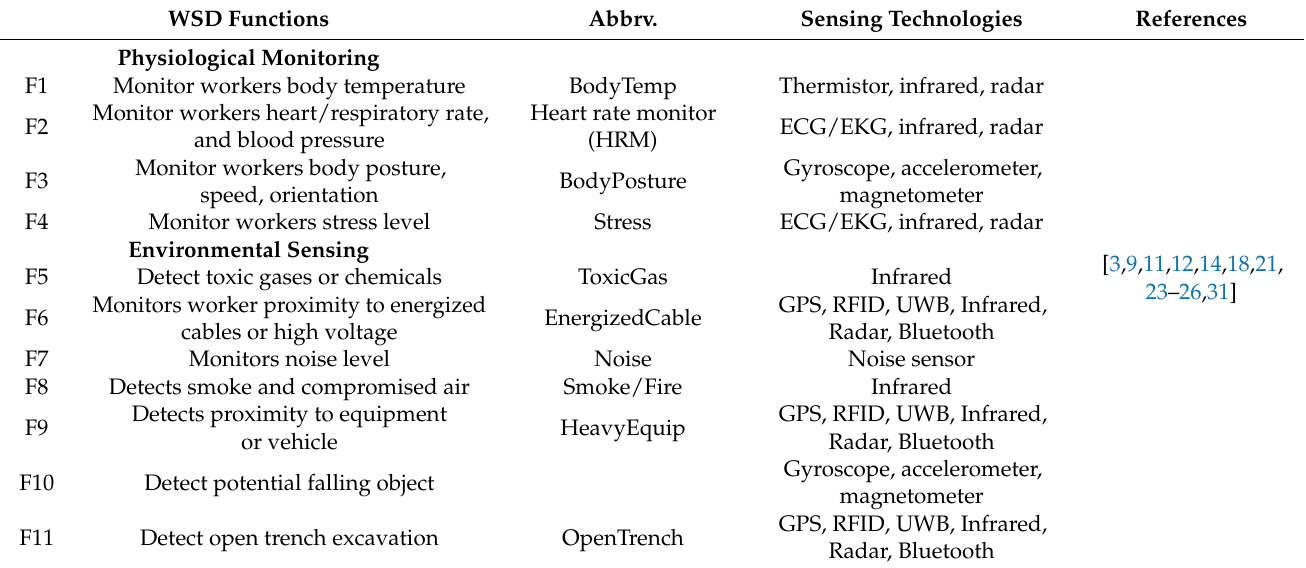
Table 1. Wearable sensing devices’ (WSDs) functions and sensor